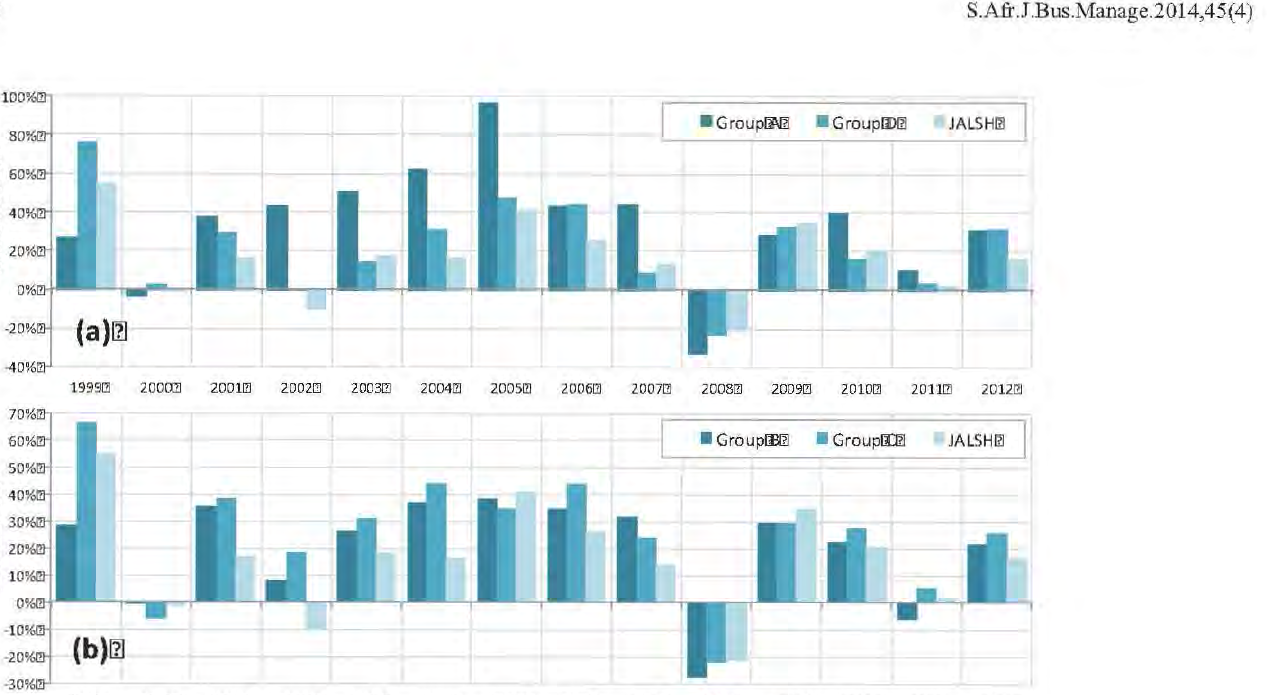
Figure 5: Portfolio and JALSH returns by year based on firm size, 1999-2012 for (a) groups A and D and (b) groups B